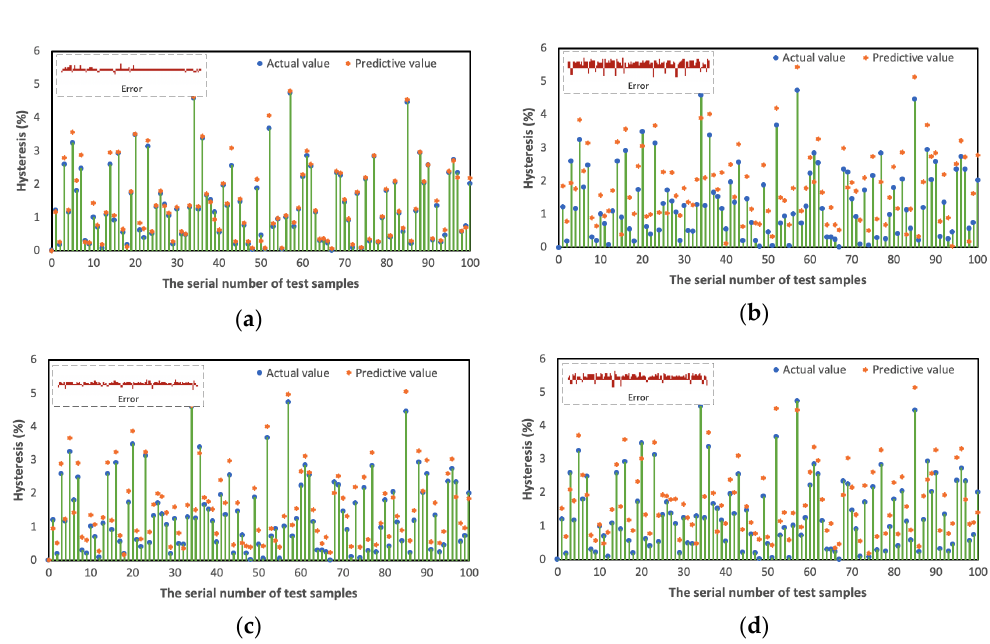
Figure 8. The prediction effect of each model. (( a ) IE-TrAdaboost; ( b ) IE-ANN; ( c ) IE-SVR; ( d ) IE-RF). (2) Comparison of performance evaluation of different prediction models